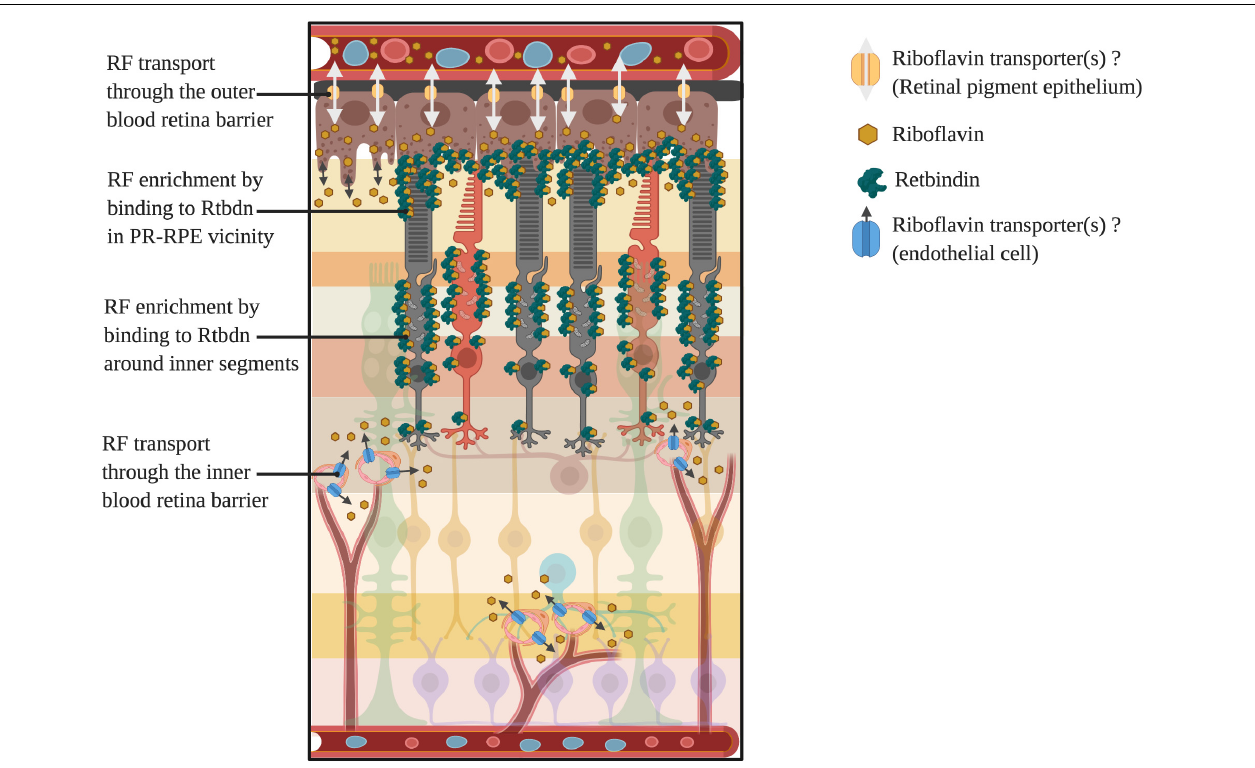
FIGURE 3 | Potential routes of flavin transport into and out of the retina and enrichment around photoreceptors. Here we have shown the two potential routes for inflow and outflow of riboflavin through yet to be identified transporters present in both the RPE (outer blood retina barrier) and endothelial cells (inner blood retina barrier). Also shown is the localization of the retinal riboflavin binding protein, retbindin, and its enrichment of bound flavins around the photoreceptor inner segments and RPE-outer segment